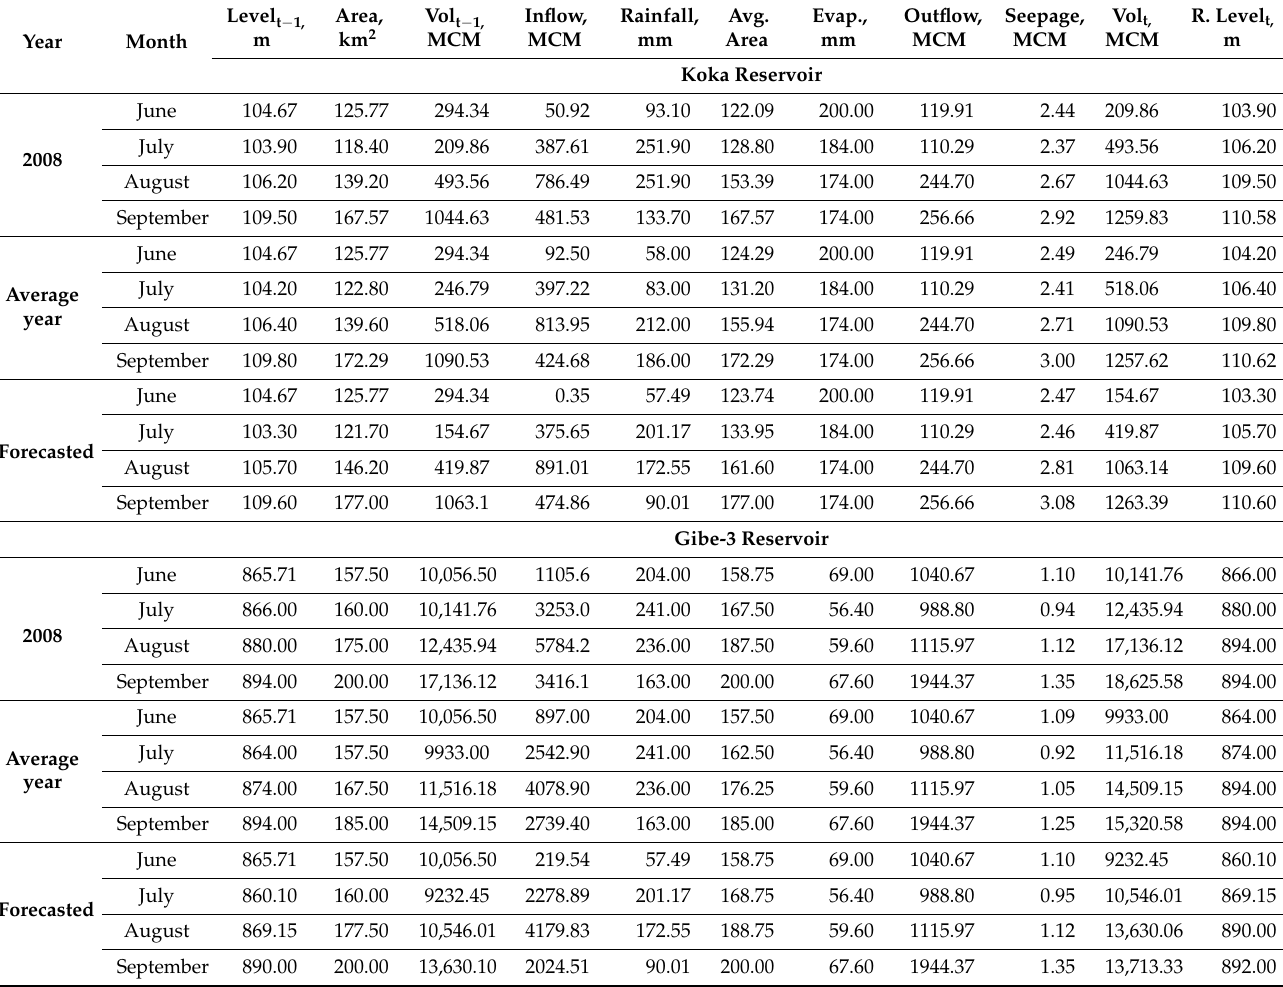
Table 5. Reservoir storage and water level forecast based on 2008, the average year, and